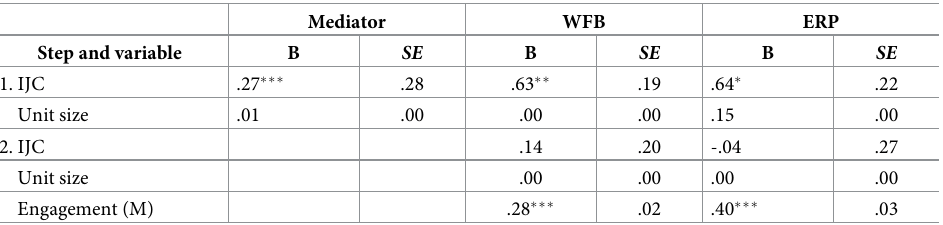
Table 3. Results for engagement hierarchical regression